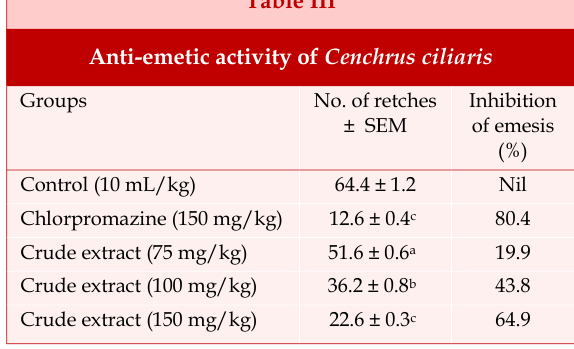
Castor oil-induced diarrhea in rats Treatments Average No. of wet feces